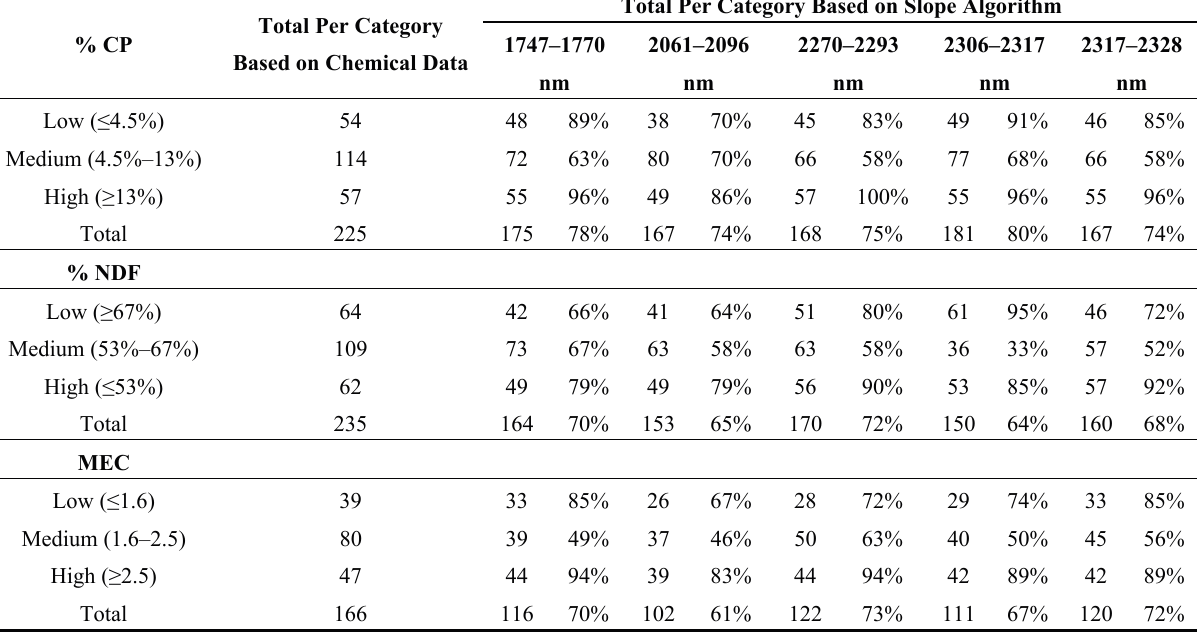
Table 4. Success rates of pasture-quality evaluations using slope algorithm. Note that chemical data were used as reference, after resampling the spectral region of FOS-5000 (700 bands